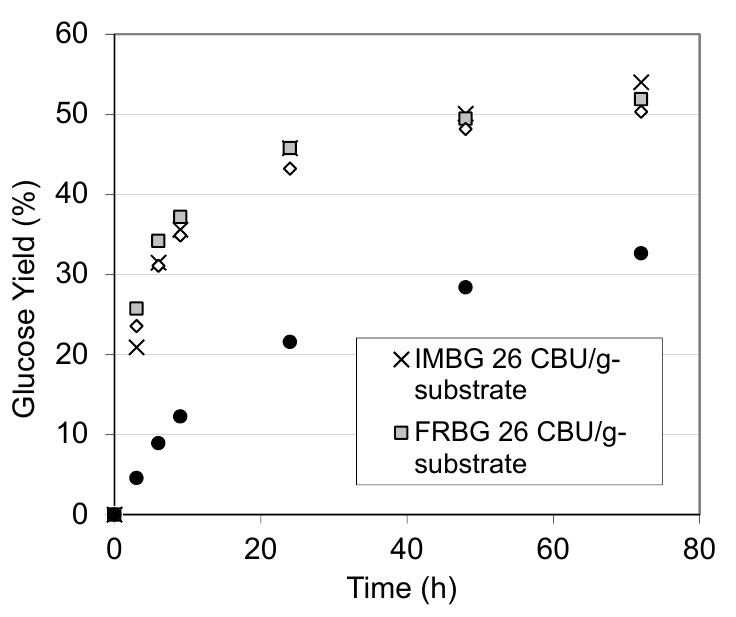
Figure 5. Time course of enzymatic hydrolysis of hydrothermally pretreated barley straw (5% dry matter w/v, reacted at 50 °C, pH 4.8) using a base dose of 8 FPU/g-substrate Celluclast 1.5 L with free (FRBG) or immobilized BG (IMBG) added at different dosages (13 or 26 CBU/g-substrate). Data points are shown as averages ±